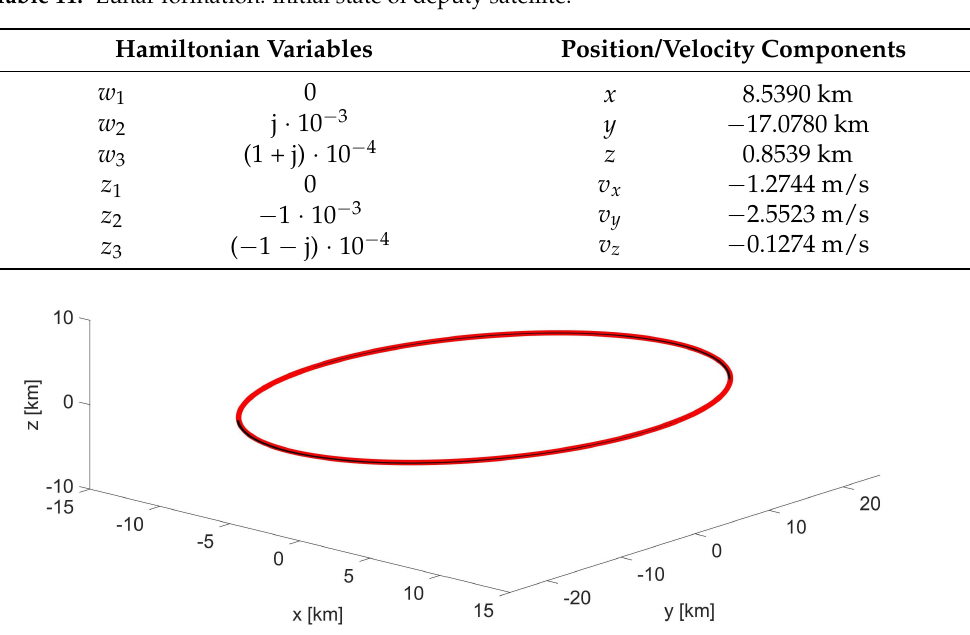
Table 11. Lunar formation: initial state of deputy satellite.